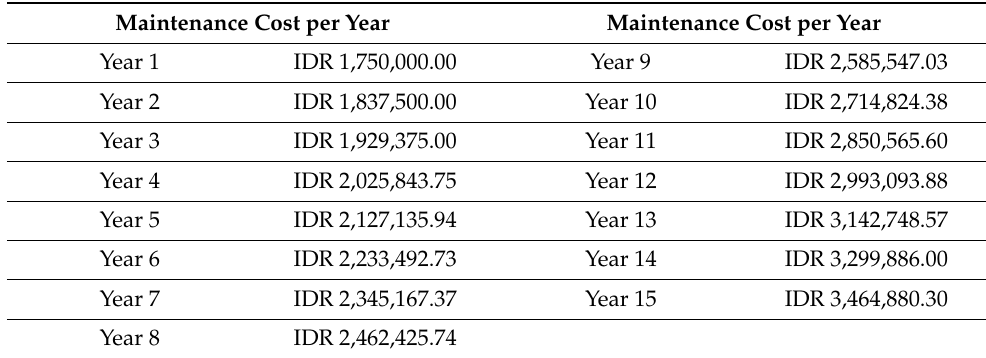
Table 10. Maintenance costs every year for 15